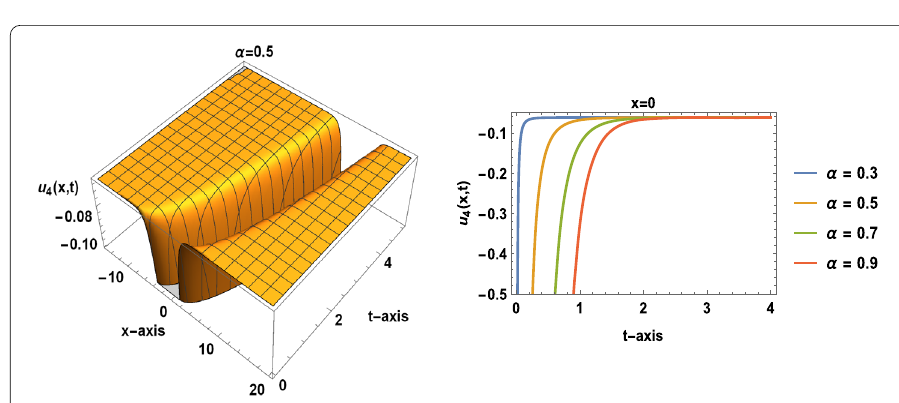
Figure 2 Graphical depiction of the solution given in Eq. (29) when k = 2, s = 0.8, w = 1